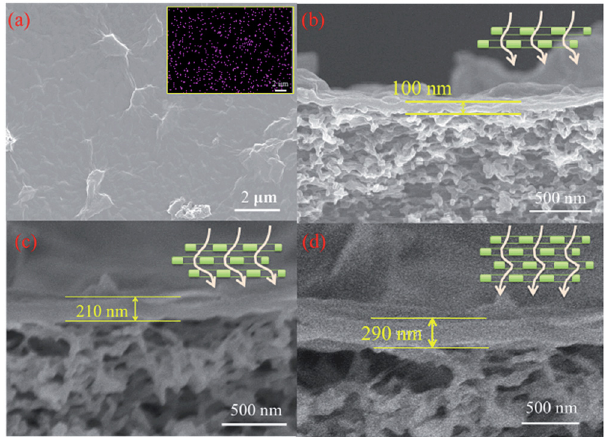
Figure 9. Top view SEM image of ( a ) the 100 nm membrane, and cross-sectional SEM images of the membranes with different thickness 100 nm ( b ), 210 nm ( c ), and 290 nm ( d ). The inset in ( a ) is the corresponding nitrogen EDS mapping, and the inserts in ( b – d ) are corresponding schematic representations of different numbers of restacked layers. Reprinted with permission from [82], The Royal Society of Chemistry, Copyright (2016).